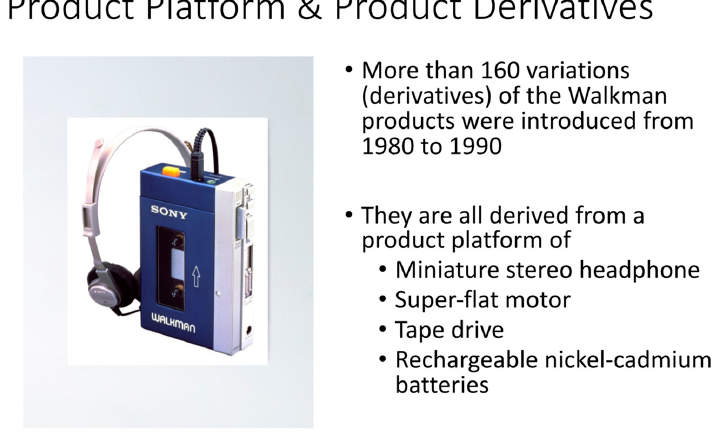
Figure 2. A particular model derived from The SONY Product Platform [11] (Meyer and Lehnerd